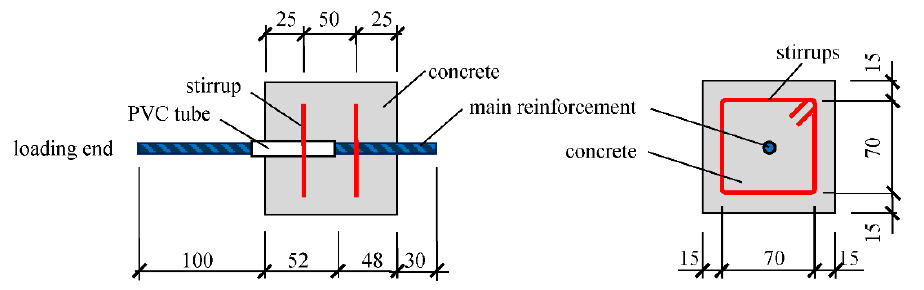
Figure 1. Layout of steel bars and size of bond specimen (size: mm).